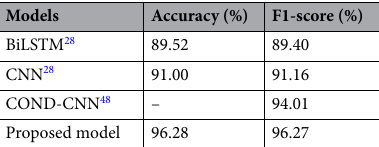
Table 9. Performance comparison of the proposed model with various DL-based models on the PAMAP2 dataset.